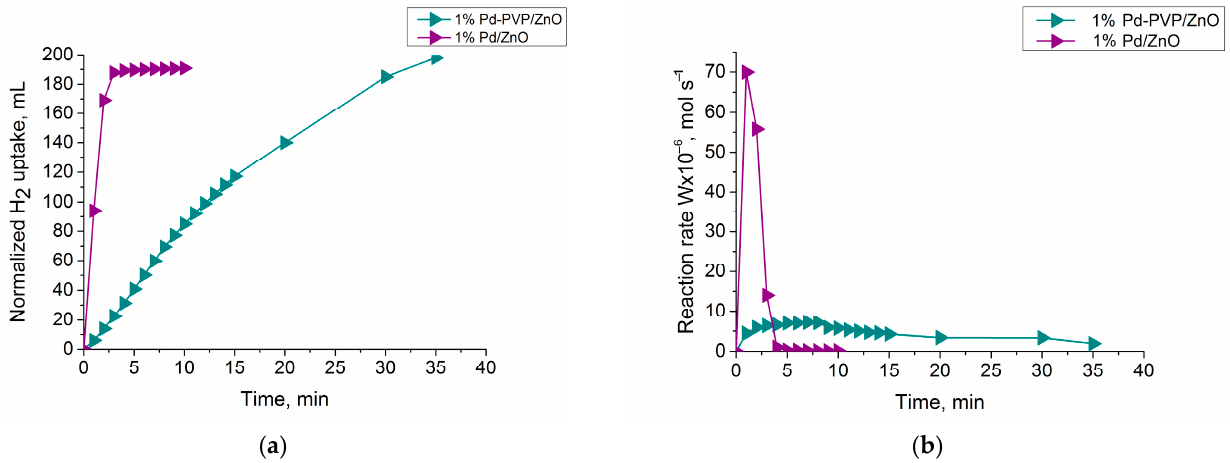
Figure 7. Kinetics of the hydrogen uptake ( a ) and change in reaction rate ( b ) on 1%Pd-PVP/ZnO and 1%Pd/ZnO catalysts during the hydrogenation of 3,7,11-trimethyldodecyn-1-ol-3 to 3,7,11-trimethyldodecen-1-ol-3 and 3,7,11-trimethyldodecan-1-ol-3. Reaction conditions: T = 40 °C, P H2 = 1 atm, m cat = 0.05 g, solvent C 2 H 5 OH 0.25 mL, and C alkynol = 0.09 mol/L.